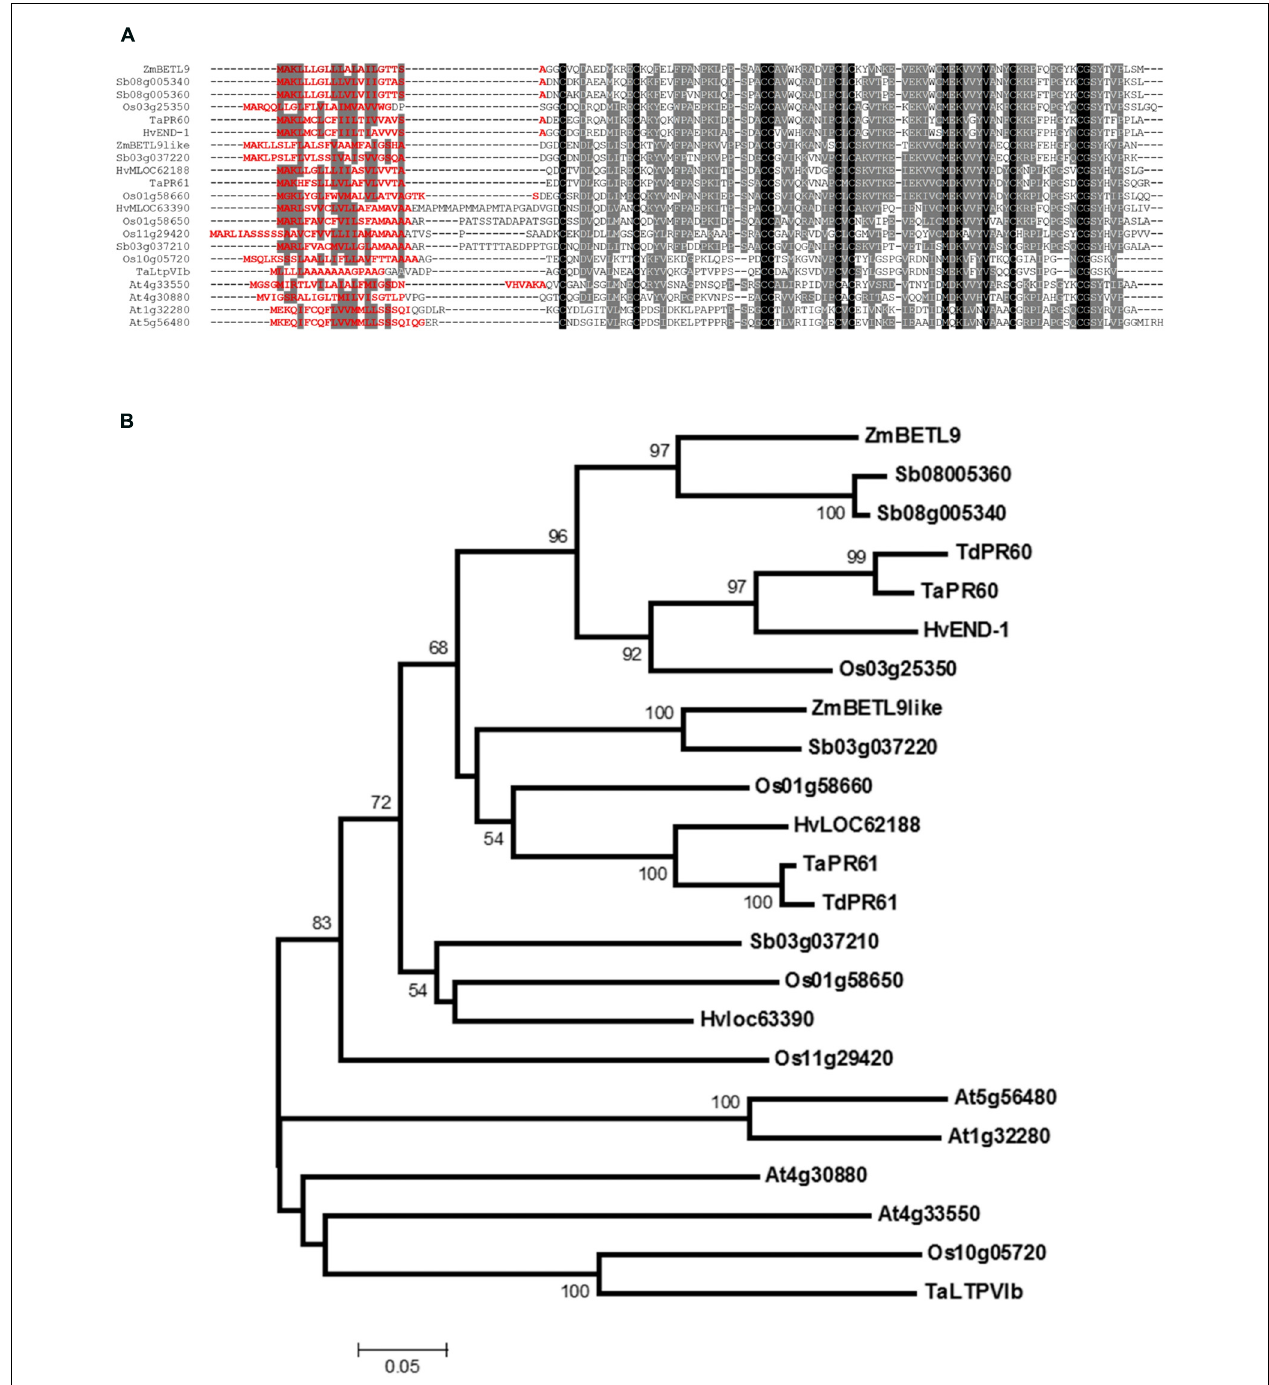
boxes. Signal peptides were predicted using SignalP 4.1 (Peterson etal., 2011) and their sequences are shown in red. (B) Phylogenetic relationships of the nsLTPs protein from typeVI.The analysis is based on the alignment of the proteins shown in A , excluding the N-terminal signal peptides, plus the Triticum durum TdPR60 andTdPR61 proteins.The Neighbor-Joining tree was constructed using MEGA 5.2 with 1000 bootstrap replicates and the p -distance and pairwise deletion options. Only bootstrap values above 50% are